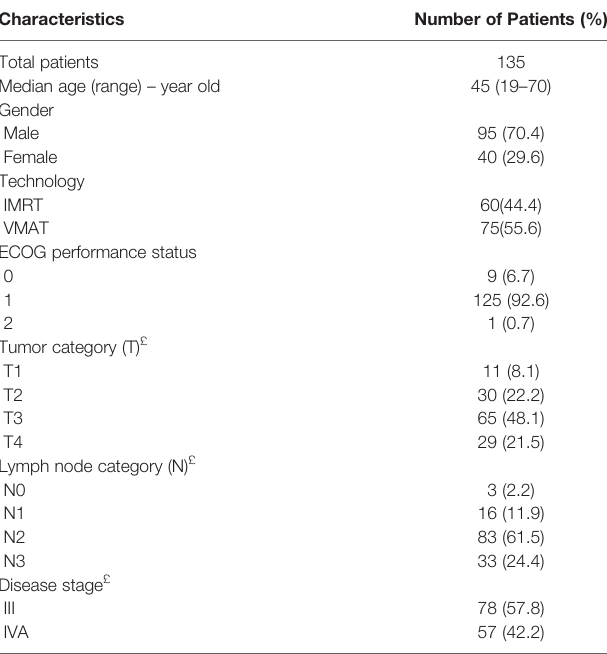
TABLE 1 | Patient clinicopathological characteristics at